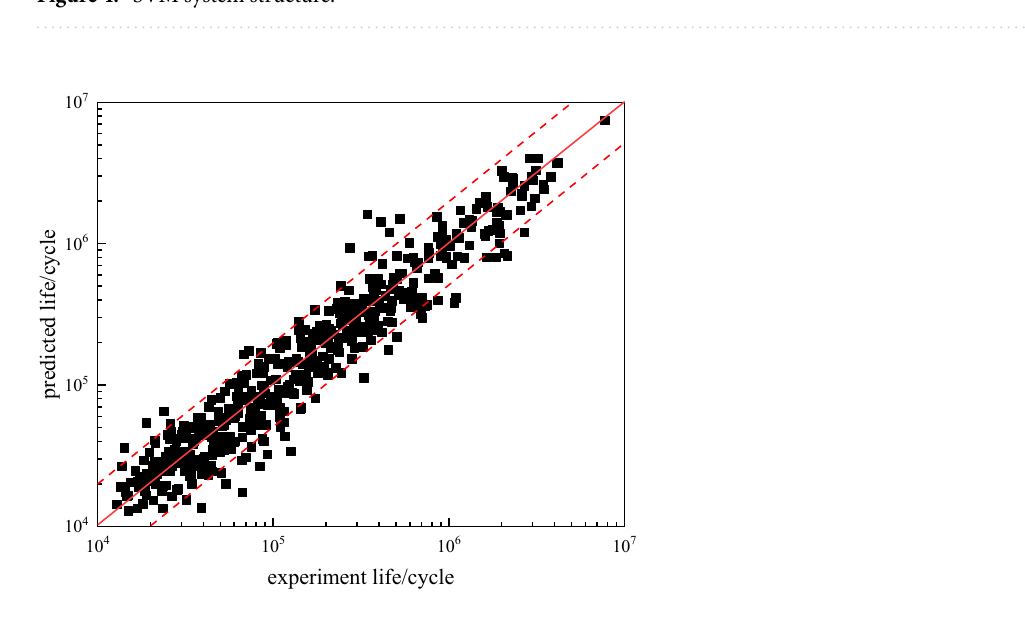
Figure 5. BP neural network training